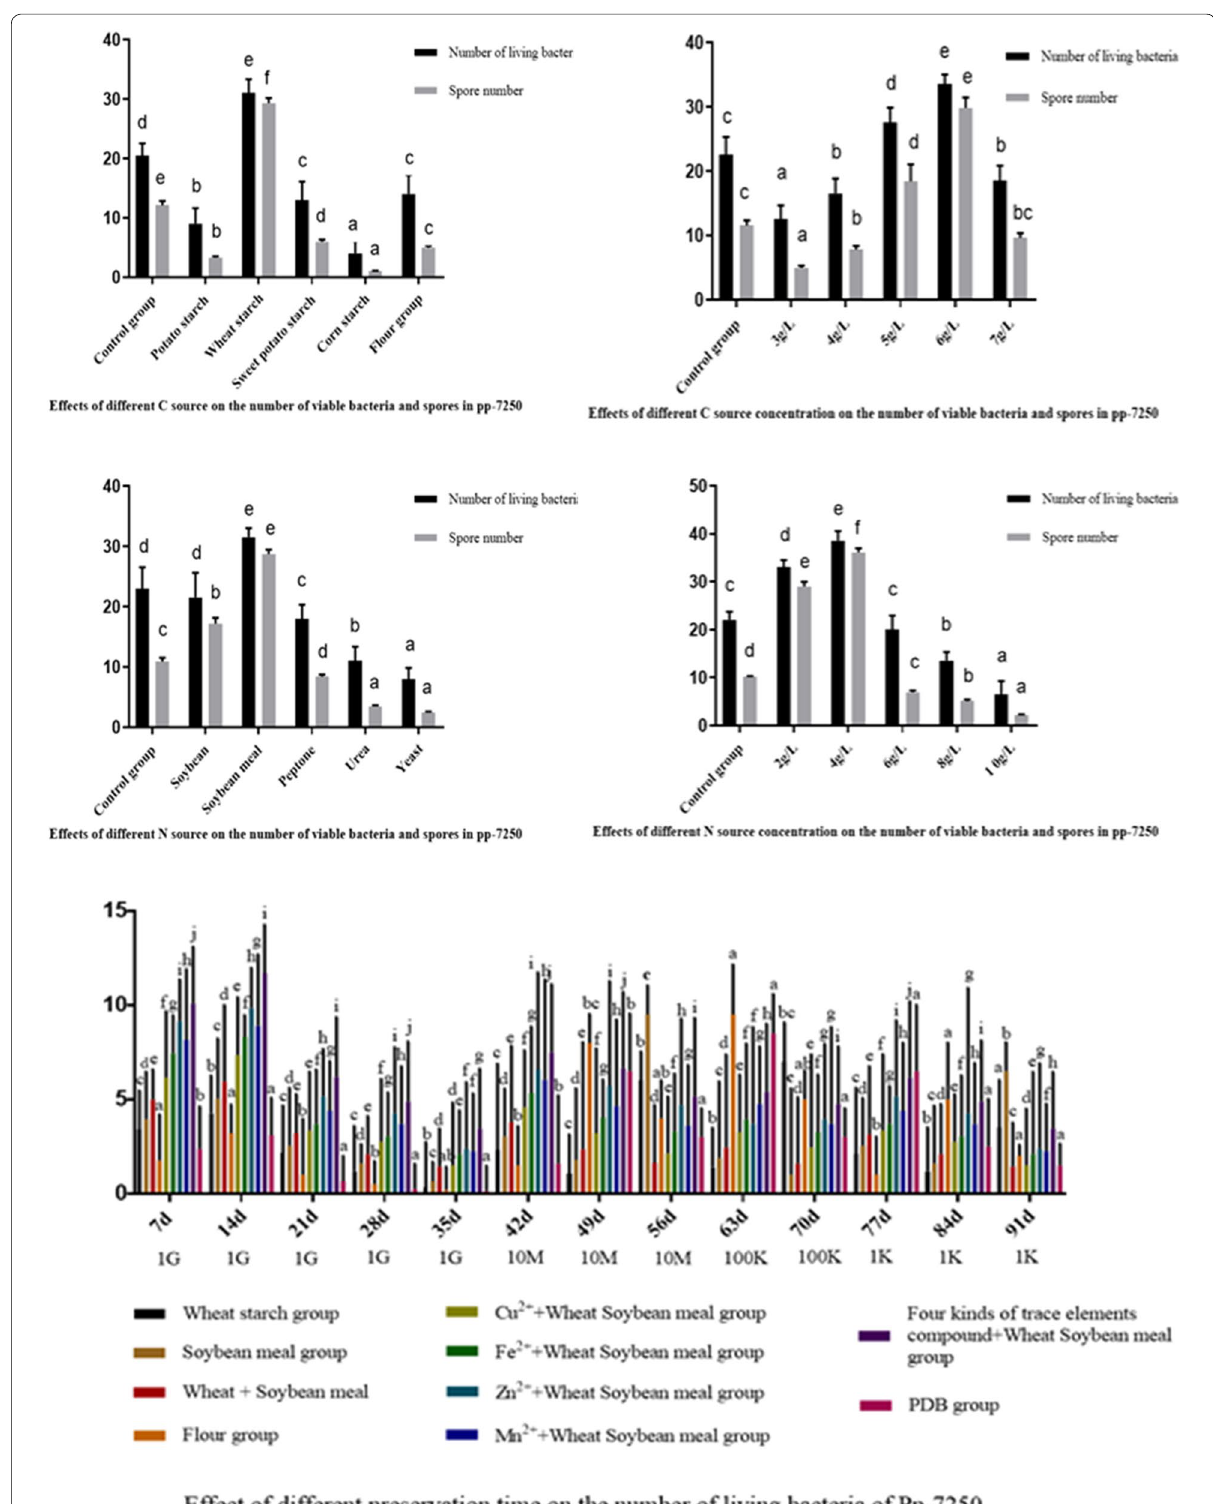
Fig. 2 The best C and N source types, concentration screening and the effect of different preservation time on the number of living bacteria of Pp-7250. a, Mucor sp.; b, Fusarium sp.; c, Geotrichum candidum ; d,